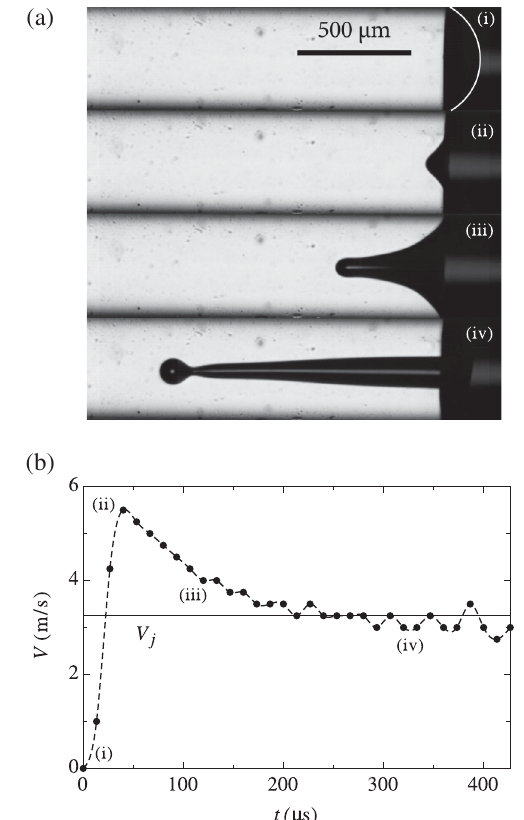
FIG. 4. (a) Jet evolution after focusing the laser in a 500 - (cid:1) m capillary tube. The first image shows the tube at the moment that the laser is fired. The subsequent images are taken at later stages, each corresponding to a point in time shown in (b). (See Ref. [32] for the related movie.) (b) Velocity of the jet tip in a 500 - (cid:1) m tube as a function of time after the laser is fired.